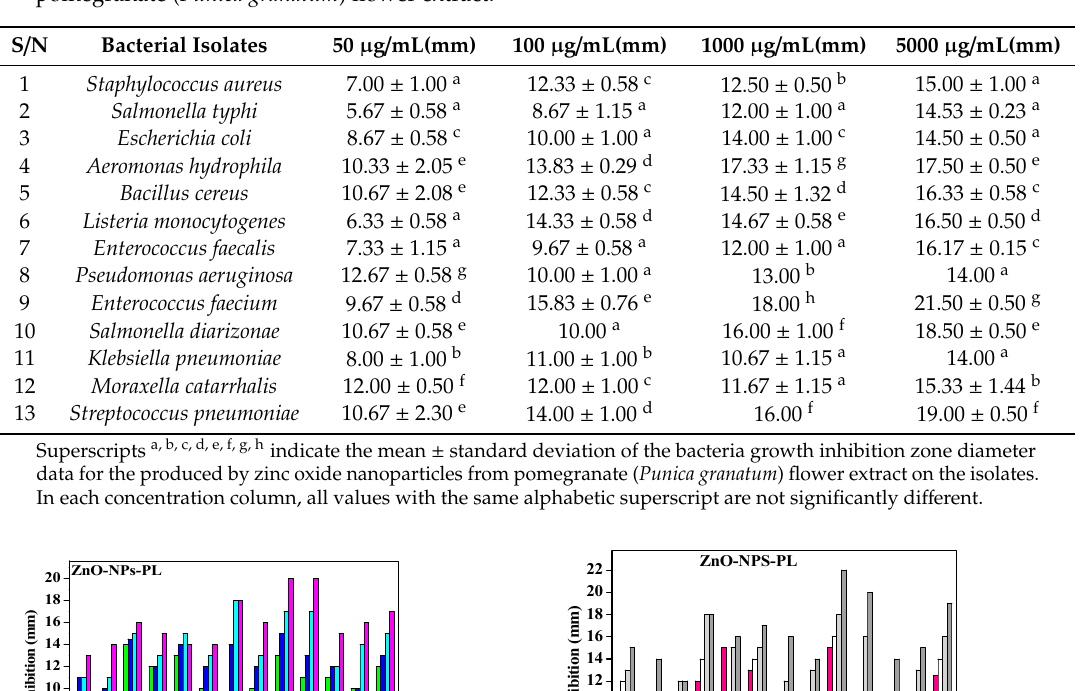
Table 4. Mean zones of inhibition value (mm) produced by zinc oxide nanoparticles mediated via pomegranate ( Punica granatum ) flower extract.